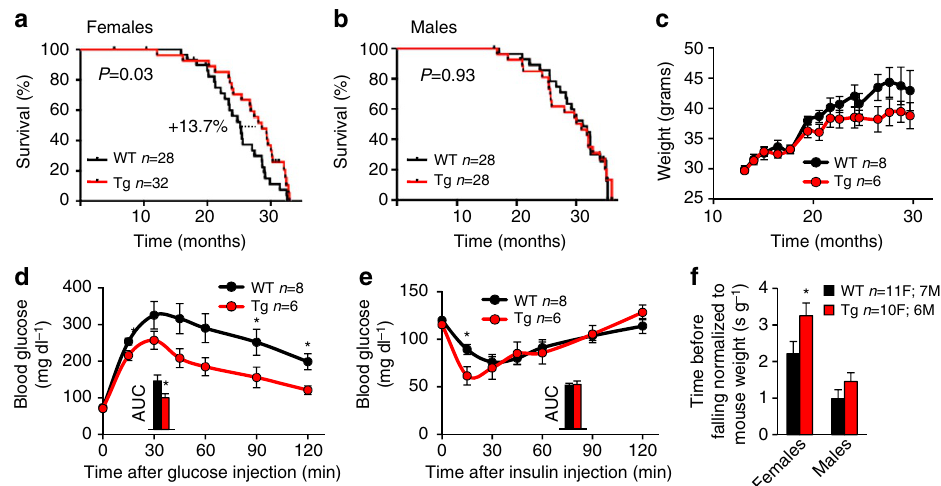
Figure 2 | G6PD-Tg mice display improved healthspan. ( a , b ) Survival curves of female ( a ) and male ( b ) mice of the indicated genotypes. ( c ) Weight of males during the indicated time. ( d , e ) GTT ( d ) and ITT ( e ) on 1–year-old male mice. Inset, area under the curve (AUC). ( f ) Rotarod test on 1.5–2-year-old mice. Bars and dots represent average ± s.e.m. Statistical significance was assessed using two-tailed Student’s t -test with the exception of panels a and b , where logrank test was used: * P o